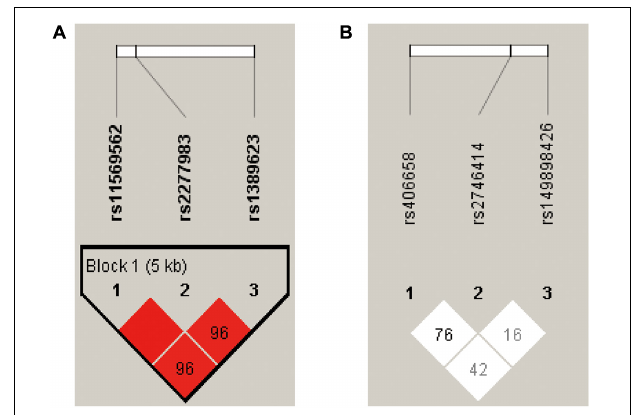
FIGURE 1 | The pairwise linkage disequilibrium (LD) analysis was applied to detect the inter-marker relationship of the three SNPs at the C3 and C4 gene receptively, by using the D ’ values. According to the D ’ values in this figure, (A) three SNPs constructed into one haplotype block in C3 gene. (B) No haplotype block was detected in C4 gene.